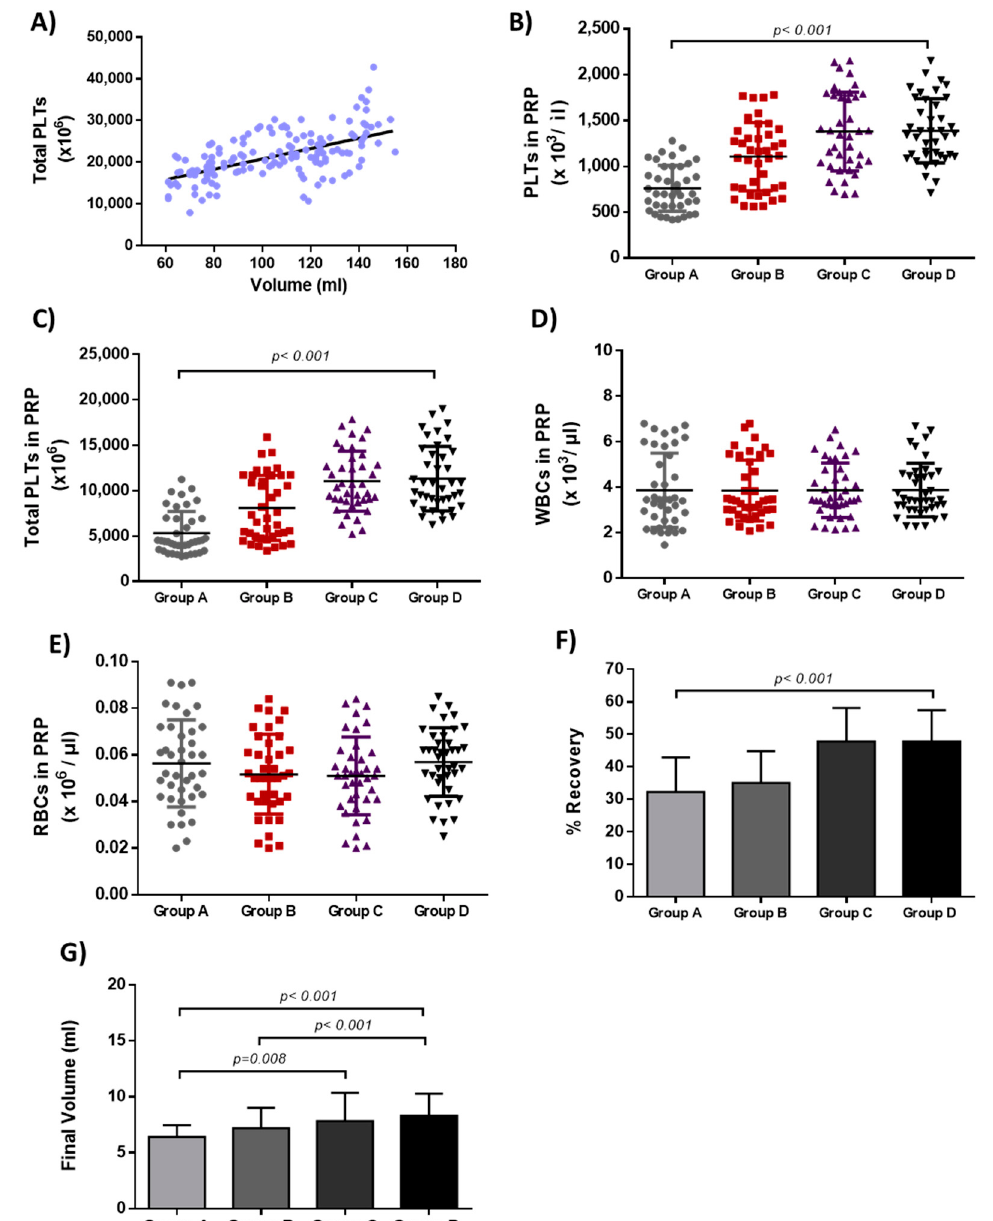
Figure 1. Characteristics of PRP samples from all groups. ( A ) Correlation between initial PLT number and initial cord blood (CB) volume, R 2 = 0.3362. ( B ) PLT concentration in PRP samples derived from all groups. Statistically significant di ff erences were observed in PLT concentration between groups A–D ( p < 0.001). ( C ) Total number of PLTs in PRP samples derived from all groups. Statistically significant di ff erences were observed in total PLT number between groups A–D ( p < 0.001). ( D ) White blood cell (WBC) concentration in PRP samples derived from all groups. ( E ) Red blood cell (RBC) concentration in PRP samples derived from all groups. ( F ) PLT recovery in PRP samples. Statistically significant di ff erences were observed in PLT recovery between all groups ( p < 0.001). ( G ) Final volume of PRP samples. Statistically significant di ff erences were observed between group A and group C ( p = 0.008) and D ( p < 0.001), and between group B and group D ( p < 0.001).